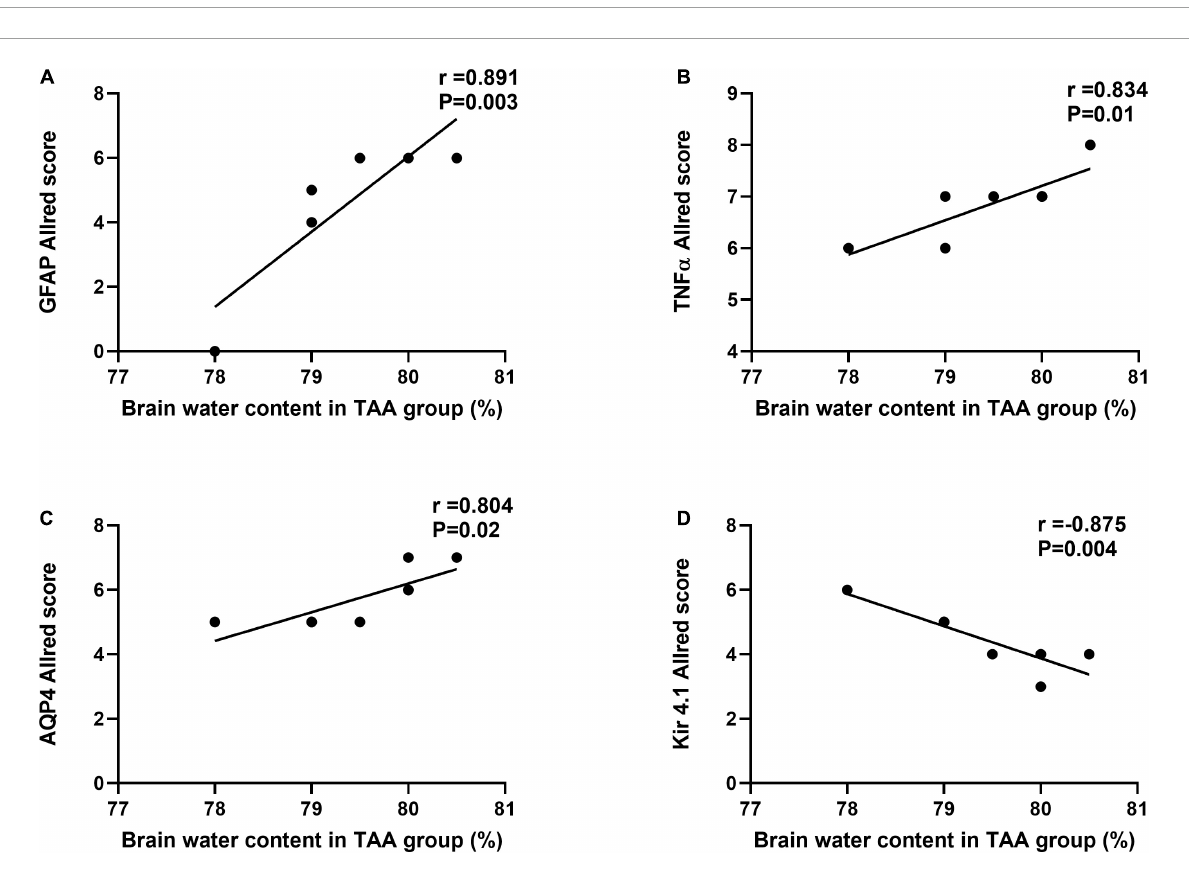
FIGURE13 Correlations between Allred score of GFAP (A) , TNF- α (B) , AQP4 (C) , and Kir 4.1 (D) and brain water content in TAA administrated group. Significant positive correlations were noted for GFAP, TNF α , and AQP4, while Kir 4.1 was negatively